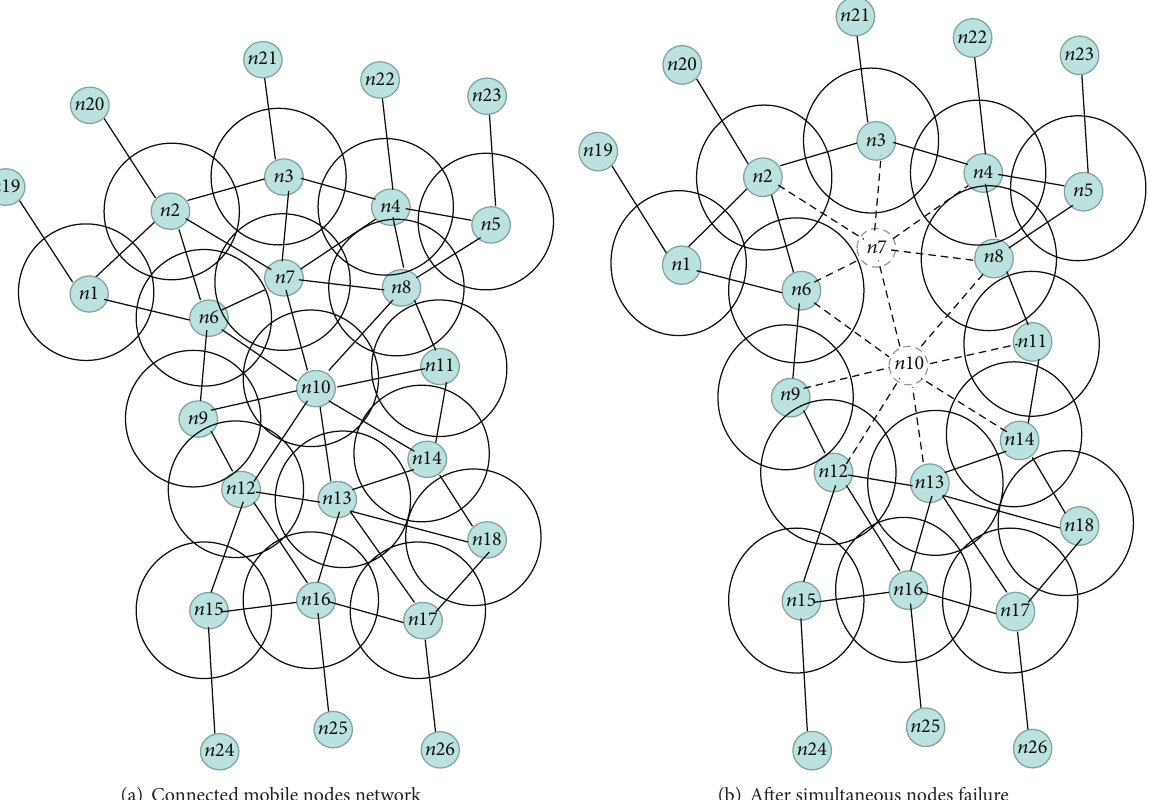
Figure 1: A connected network of mobile node. Individual node denoted the communication